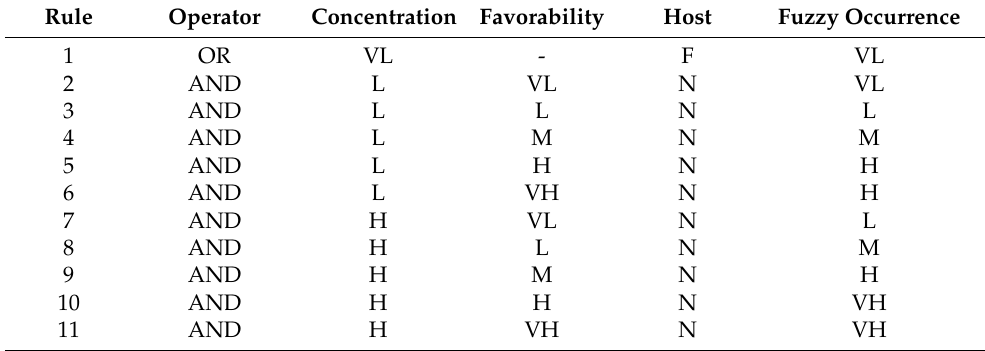
Table 2. Fuzzy rule base for FRS.